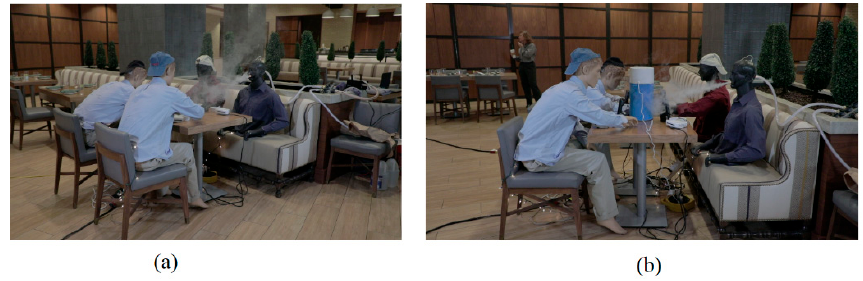
Figure 14. The dispersion processes of stage fog ( a ) without and ( b ) with purifier in a restaurant.